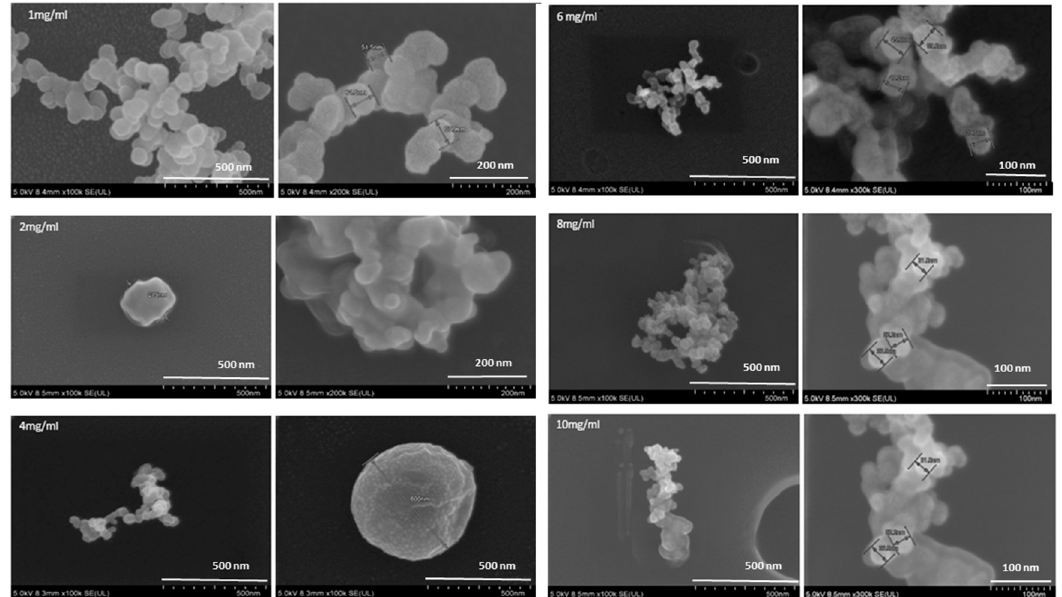
Figure 5. FESEM analysis of the blank NaCNs formulated with 1, 2, 4, 6, 8 and 10 mg/mL concentrations taken after one hour of mixing. Pharmaceutics 2020 , 12 , x FOR PEER REVIEW